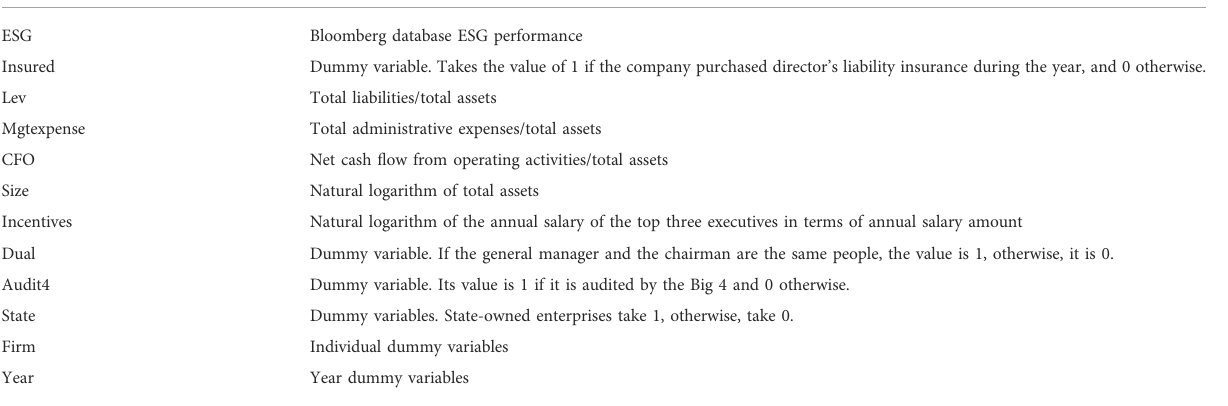
TABLE A1 De fi nition of